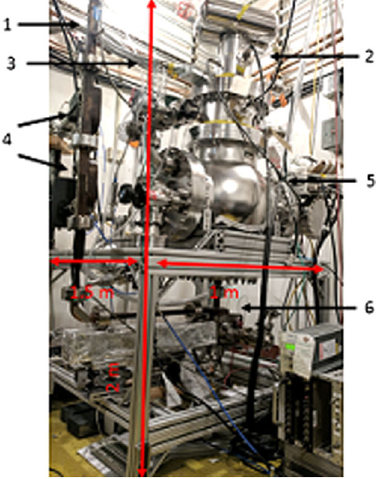
FIG. 5. Photo of experimental setup: (1) WR90 waveguide towards the klystron; (2) pulse tube cooler; (3) helium lines; (4) WR90 directional couplers; (5) vacuum chamber of the cryostat; (6) TM 01 mode